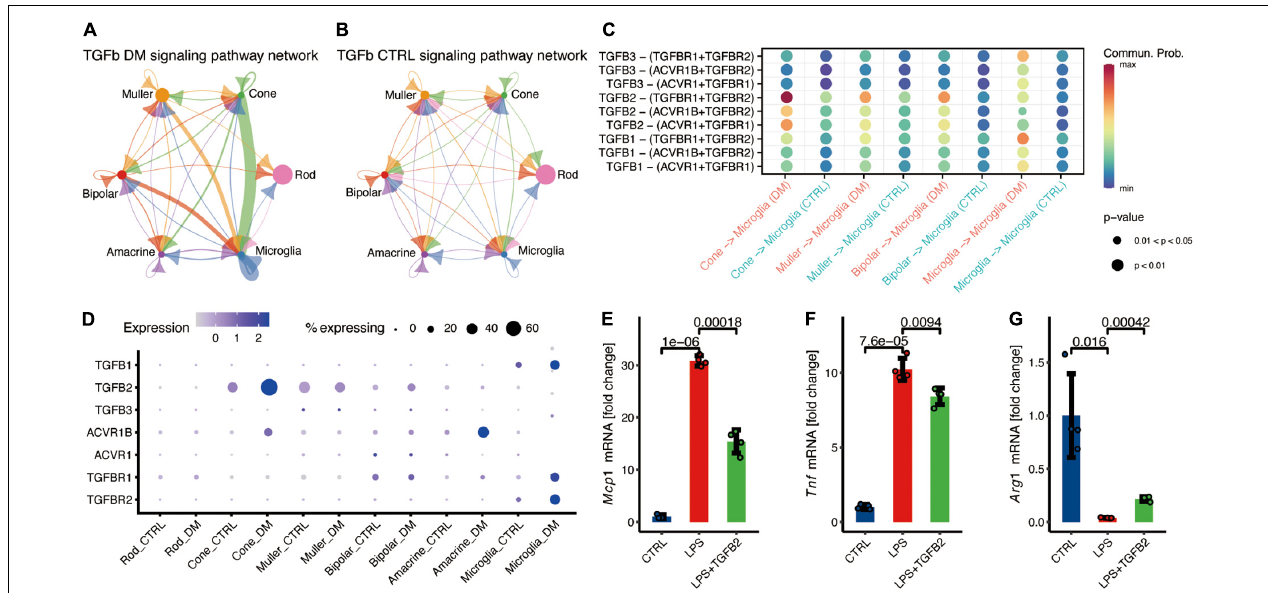
FIGURE 4 | Cone communicate with microglia via TGF β signaling pathway, potentially suppress the microglia inflammation. (A,B) The inferred TGF β signaling networks in the retina of DM (A) and control monkeys (B) . (C) Comparison of significant ligand-receptor pairs of TGF β signaling pathway between DM and control retina. (D) Expression distribution of TGF β signaling genes. (E–G) Fold change to control based on the relative expression of Mcp1 (E) , Tnf (F) , and Arg1 (G) . Data are presented as Mean + SD from four individual experiments, p values was calculated using two-sided t